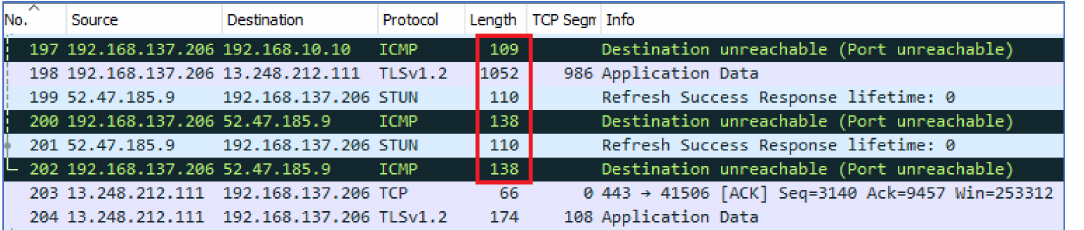
Figure 12. The traffic pattern of ending calls from User A to User B.